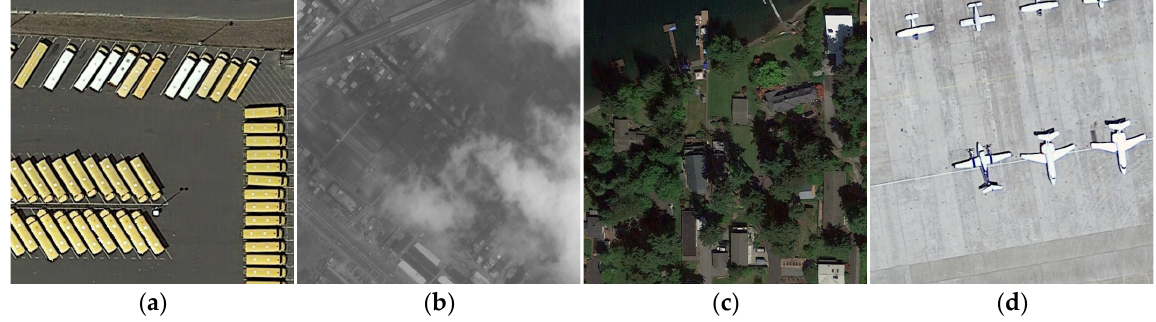
Figure 1. Remote sensing images with ( a ) densely packed vehicles, ( b ) color distortion, cloud and fog noise, ( c ) complex background, and ( d ) high similarity between helicopters and planes.